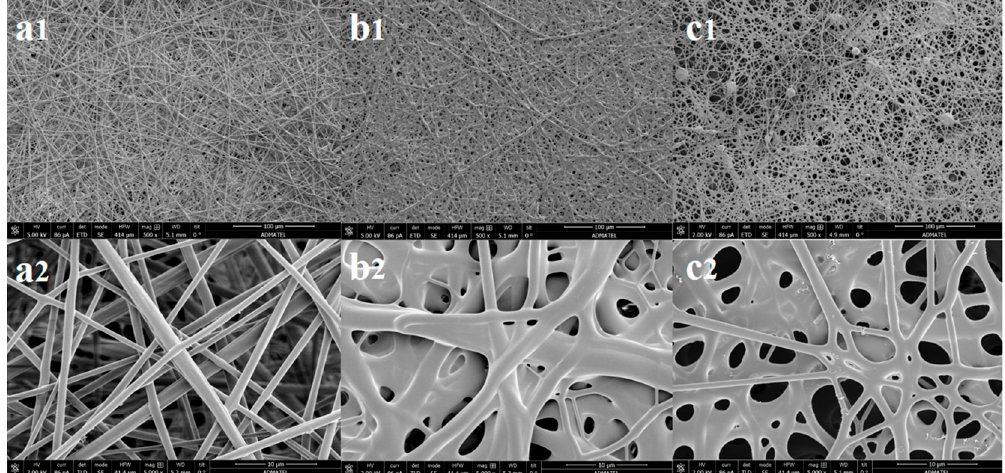
Figure 6. SEM micrographs of electrospun nanofibers of ( a1 , a2 ) ES ‐ SDIB/PBz ‐ 0; ( b1 , b2 ) ES ‐ SDIB/PBz ‐ and ( c1 , c2 ) ES-SDIB / PBz-10; (Magnification for a1 , b1 and c1 : 500 × ; a2 , b2 and c2 : 5000 × ; scale bar: 10 5; and ( c1 , c2 ) ES ‐ SDIB/PBz ‐ 10; (Magnification for a1 , b1 and c1 : 500×; a2 , b2 and c2 : 5000×; scale bar: and 100 µ 10 and 100 μ m).